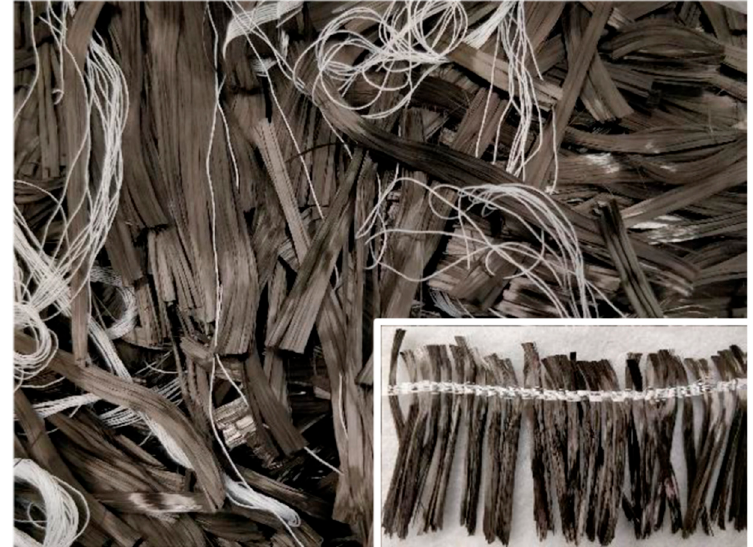
Figure 2. Carbon fibre waste produced from the stitching process.